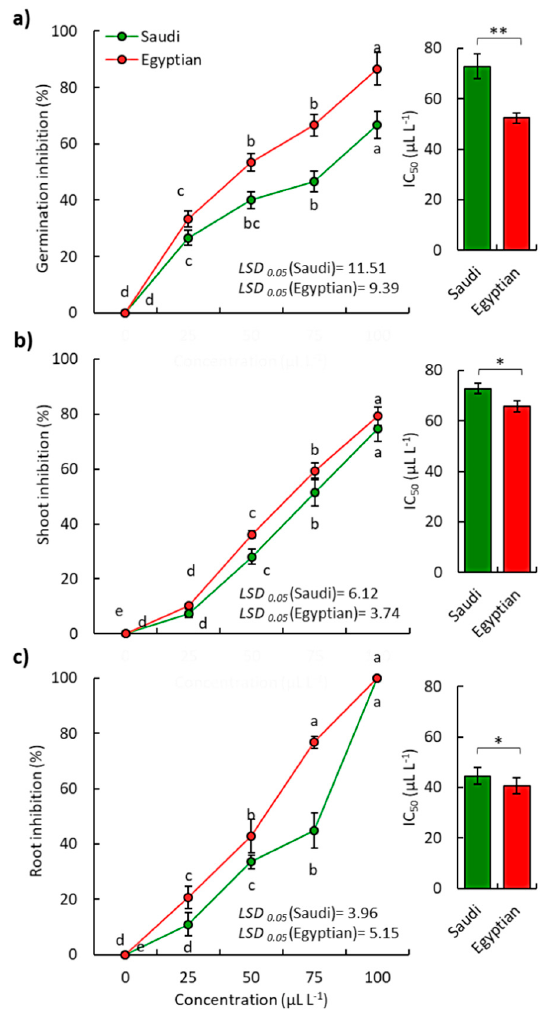
Figure 3. Phytotoxic effect of the EOs extracted from the aerial parts of both Saudi and Egyptian ecotypes of P. undulata on the ( a ) germination of seeds, ( b ) shoot growth, and ( c ) root growth of the weed Bidens pilosa . Different letters on each line mean significant differences (one-way randomized blocks ANOVA). Data are mean value ( n = 3 ), and the bars represent the standard error. * p < 0.05, ** p < 0.01.